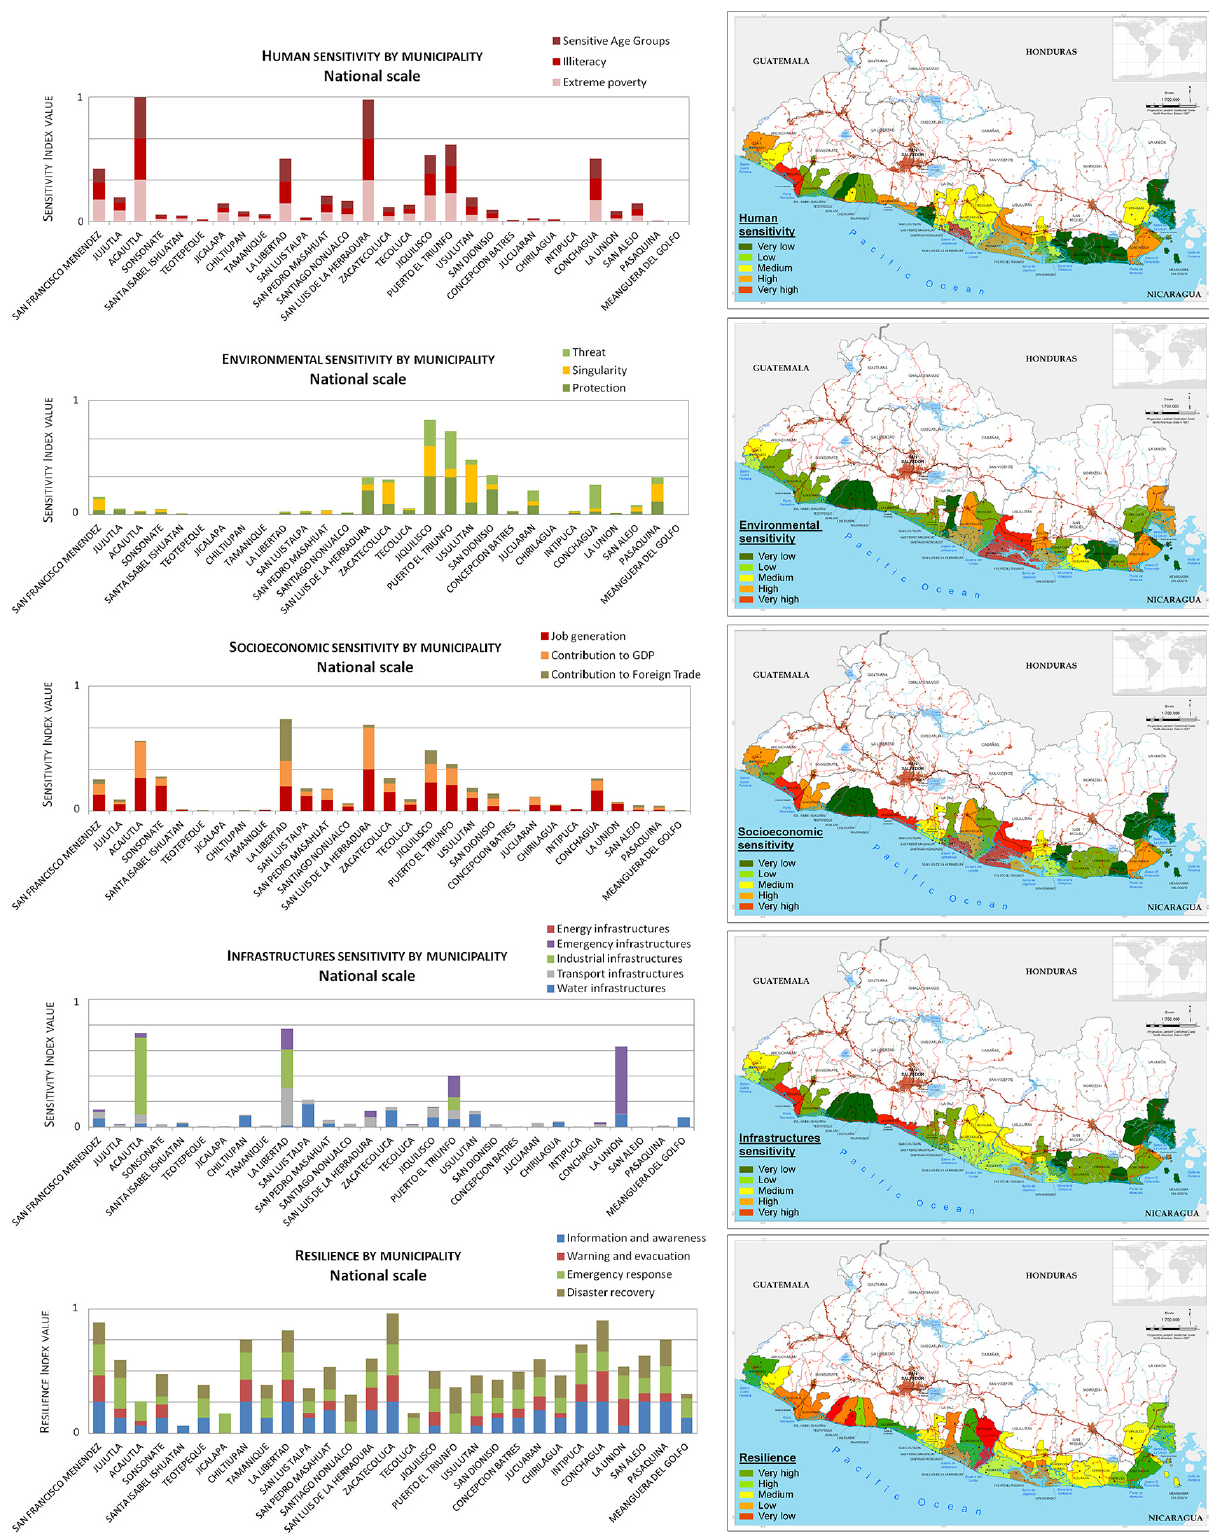
Figure 3. Vulnerability results for the El Salvadoran coastal area at the national scale by municipality: (from top to bottom) (i) human, (ii) environmental, (iii) socioeconomic and (iv) infrastructural sensitivity, and (v) community